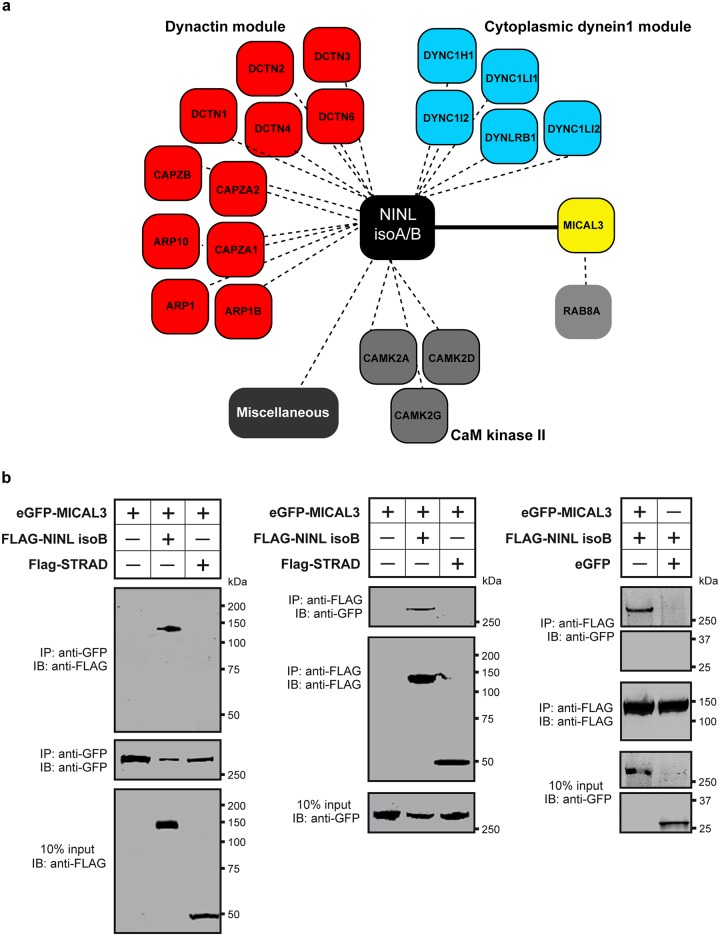
NINL interactome screen identifies MICAL3.(a) Strep-SILAC and TAP (tandem affinity purification) experiments show that NINL interacts specifically with MICAL3 (Yellow). The solid line between NINL and MICAL3 symbolizes a direct interaction, whereas the dashed lines indicate interactions determined by IP. (b) Co-immunoprecipitation of eGFP-MICAL3 with FLAG-NINLisoB, but not with FLAG-STRAD. The immunoblot (IB) in the top panel shows that eGFP-tagged MICAL3 co-immunoprecipitated with FLAG -tagged NINL (lane 2), whereas FLAG-tagged STRAD used as a negative control (lane 3) did not. The anti-GFP immunoprecipitates are shown in the middle panel; protein input is shown in the bottom panel. Reciprocal IP experiments using anti-FLAG antibodies confirmed the co-immunoprecipitation of eGFP-tagged MICAL3 with FLAG-tagged NINLisoB (lane 2) and not with STRAD (lane 3) shown in the top panel. The anti-FLAG immunoprecipitations are shown in the middle panel; protein input is shown in the bottom panel. A co-immunoprecipitation experiment using untagged eGFP as a negative control (right panel) showed that eGFP-tagged MICAL3 immunoprecipitates with FLAG-tagged NINLisoB but not with untagged eGFP.